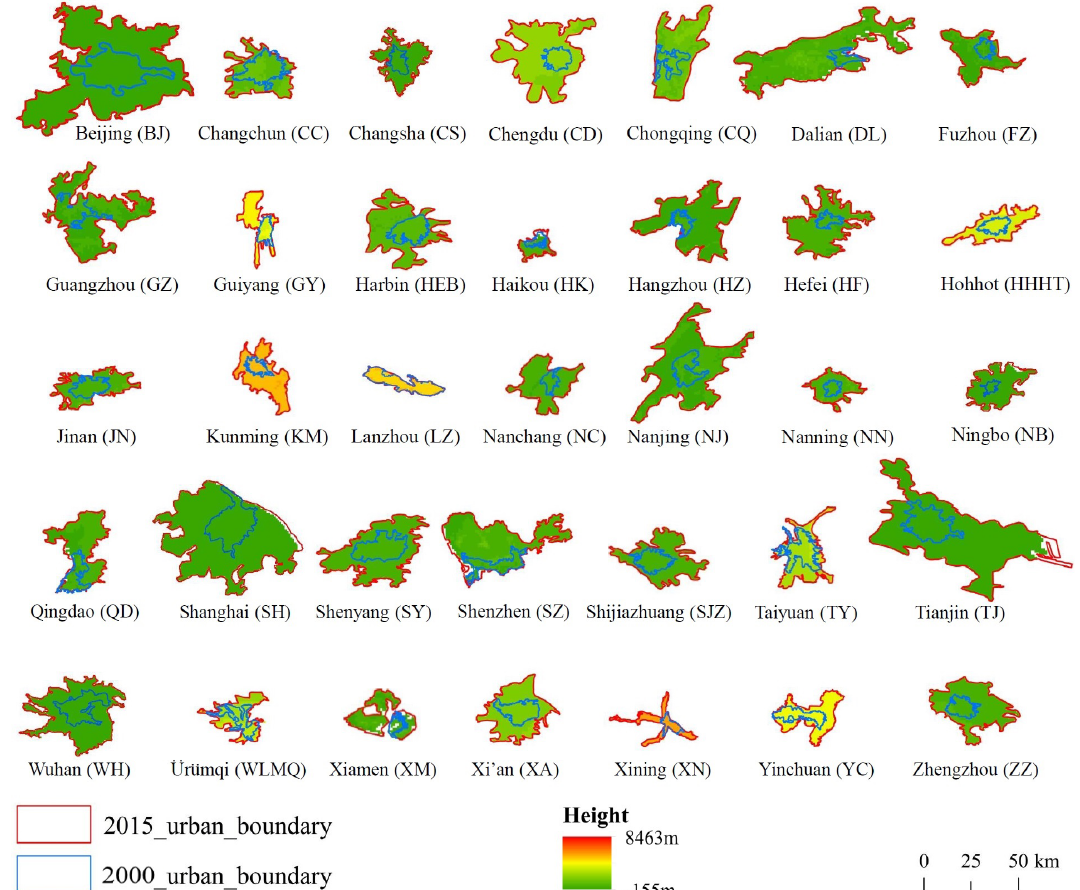
Figure 2. Main urban contours of the 35 cities. Blue contours outline urban boundaries before or in 2000, and red contours outline urban boundaries in 2015. The surface height (in meters above sea level) is indicated by colored shading. The short names of all cities were shown in